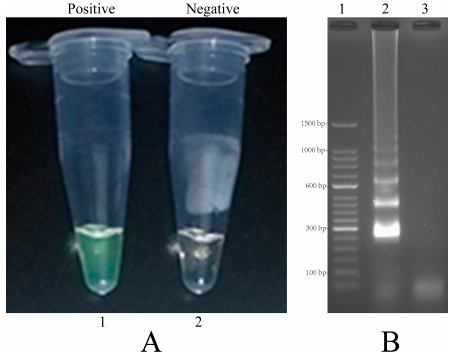
gel electrophoresis. ( A ): color change of MIP-LAMP tubes; tube 1, positive amplification; tube 2, negative amplification; ( B ): agarose gel electrophoresis of MIP-LAMP products; lane 1, DL 50-bp DNA marker; lane 2, positive nLAMP products; lane 3 negative